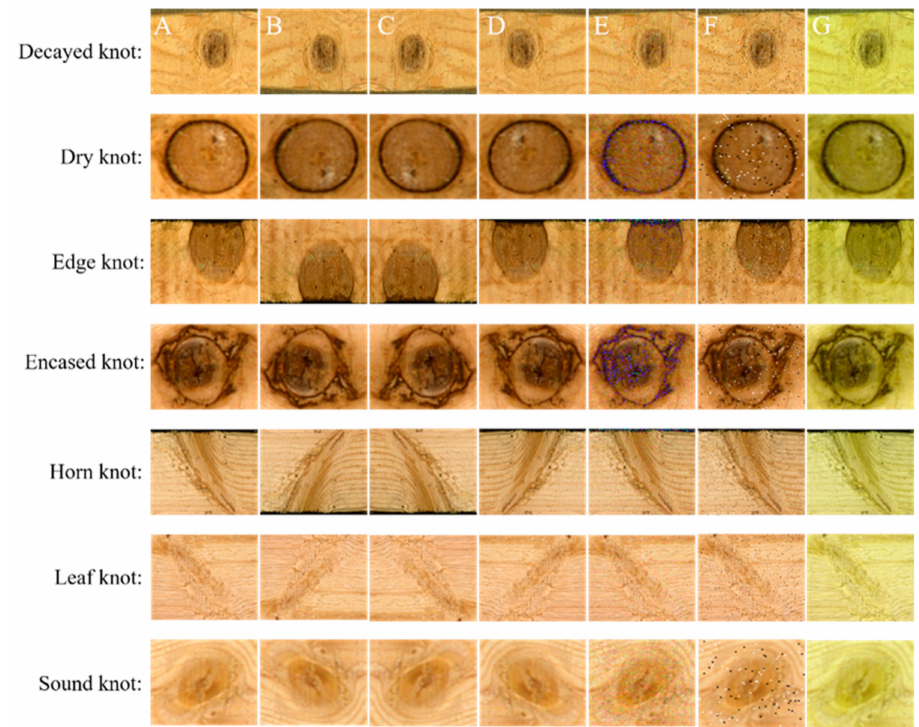
Figure 1. Seven common wood knots and data augmentation of dataset. 1. a decayed knot, 2. a dry knot, 3. an edge knot, 4. an encased knot, 5. a horn knot, 6. a leaf knot, 7. a sound knot. Original images and those created through data augmentation: ( A ) original image, ( B ) vertical mirror ( C ) rotated by 180 ◦ , ( D ) horizontal mirror, ( E ) added Gaussian noise to image, ( F ) added salt-and-pepper noise to image, and ( G ) increased the hue by